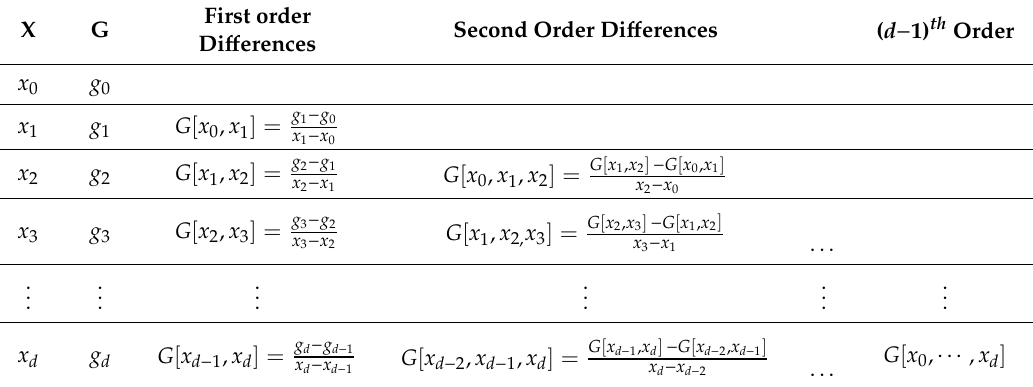
Table 1. Forward divided di ff erences table using set of points (x i , g i ) from i = 0 to i = d. First order Second Order Di ff erences ( d − 1) th Order X G Di ff erences x